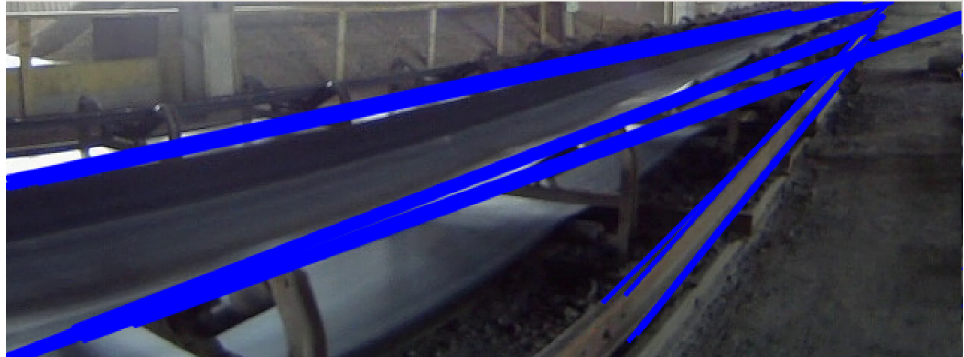
Figure 7. Exemplary effect of general line detection (Hough